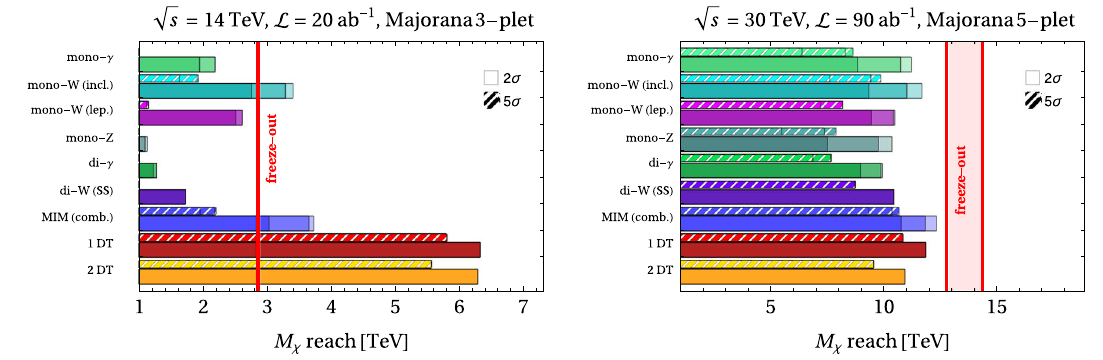
Fig. 5 Different bars show the 2 σ (solid wide) and 5 σ (hatched thin) reach on the WIMP mass at a muon collider for different search chan- nels. The first seven bars show the channels discussed in Sect. 5.1 where DM would appear as missing invariant mass (MIM) recoiling against one or more SM objects: mono-gamma, inclusive mono-W, leptonic mono-W, mono-Z, di-gamma, same sign di-W, and the combination of alltheseMIMchannels(blue).Thelasttwobarsshowthereachofdisap-